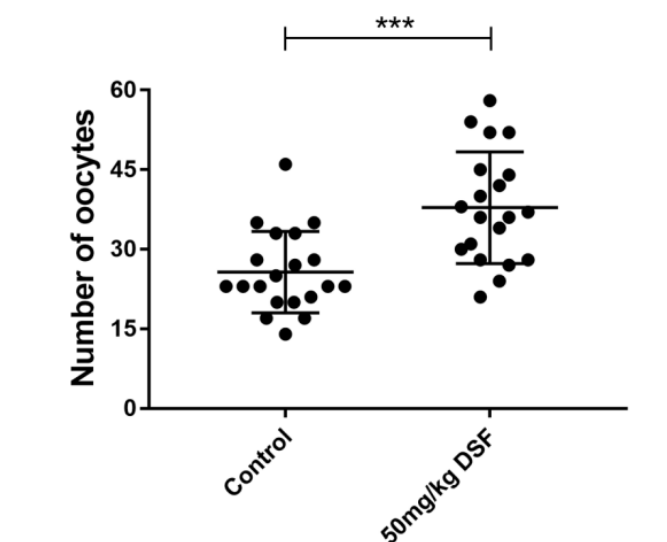
Figure 4. Effects of different concentrations of DSF on ovulation rate in mice. *** p < 0.001; Control group, n = 20; 50 mg/kg DSF group, n = 20.